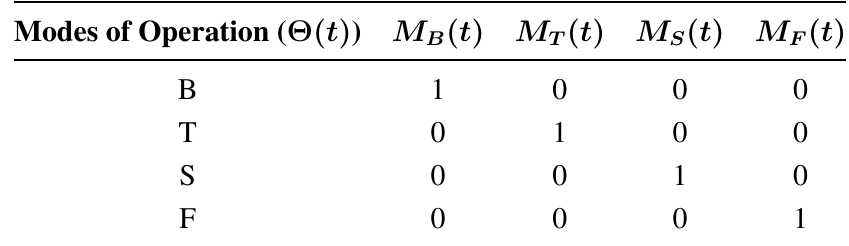
Table 1. Table of Markovian